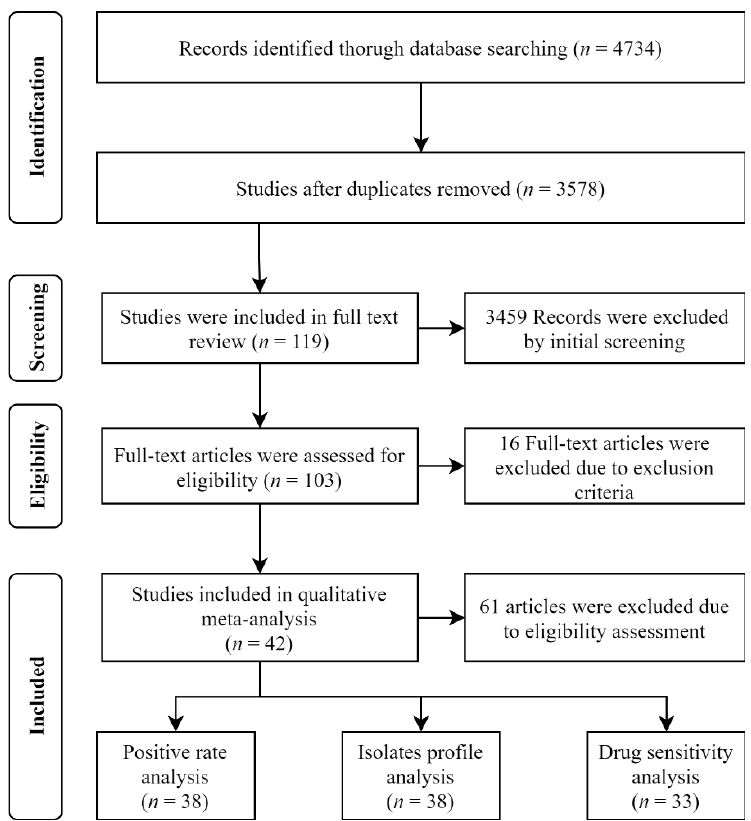
Figure 1. The PRISMA flow chart of paper selection.